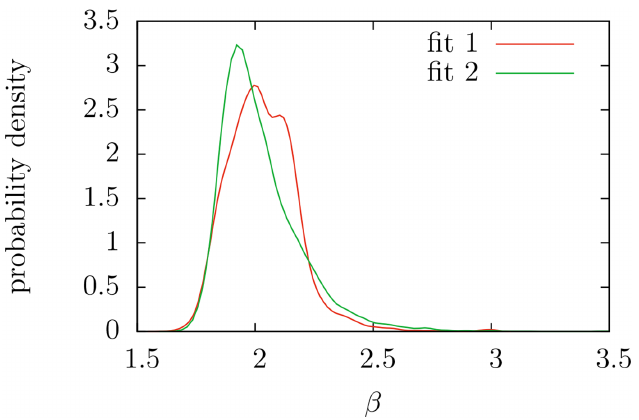
Fig 8. Estimation of the probability density of the Zipf ’ s exponent β for texts yielding p (cid:2) 0.05 in the fits of f 1 and f 2 . Curves have been calculated from the histograms via normal kernel smoothing method as implemented in MatLab ( ksdensity function). Estimated mean and standard deviation of β are 2.03 and 0.15 respectively for the fit of f 1 , and 2.02 and 0.17 for f 2